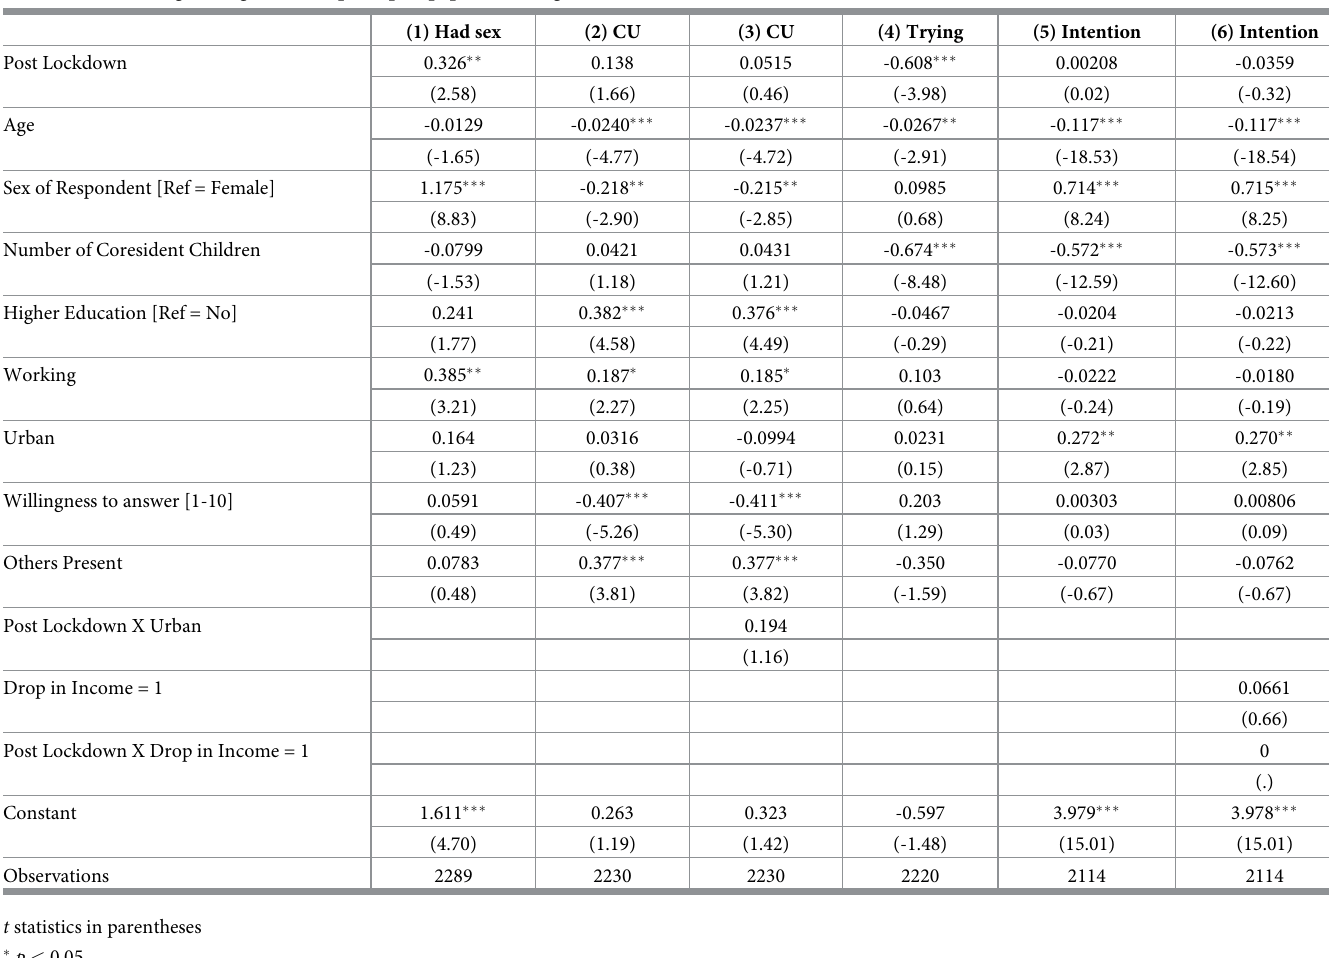
Table 3. Results of logistic regression on pre & post population [Log